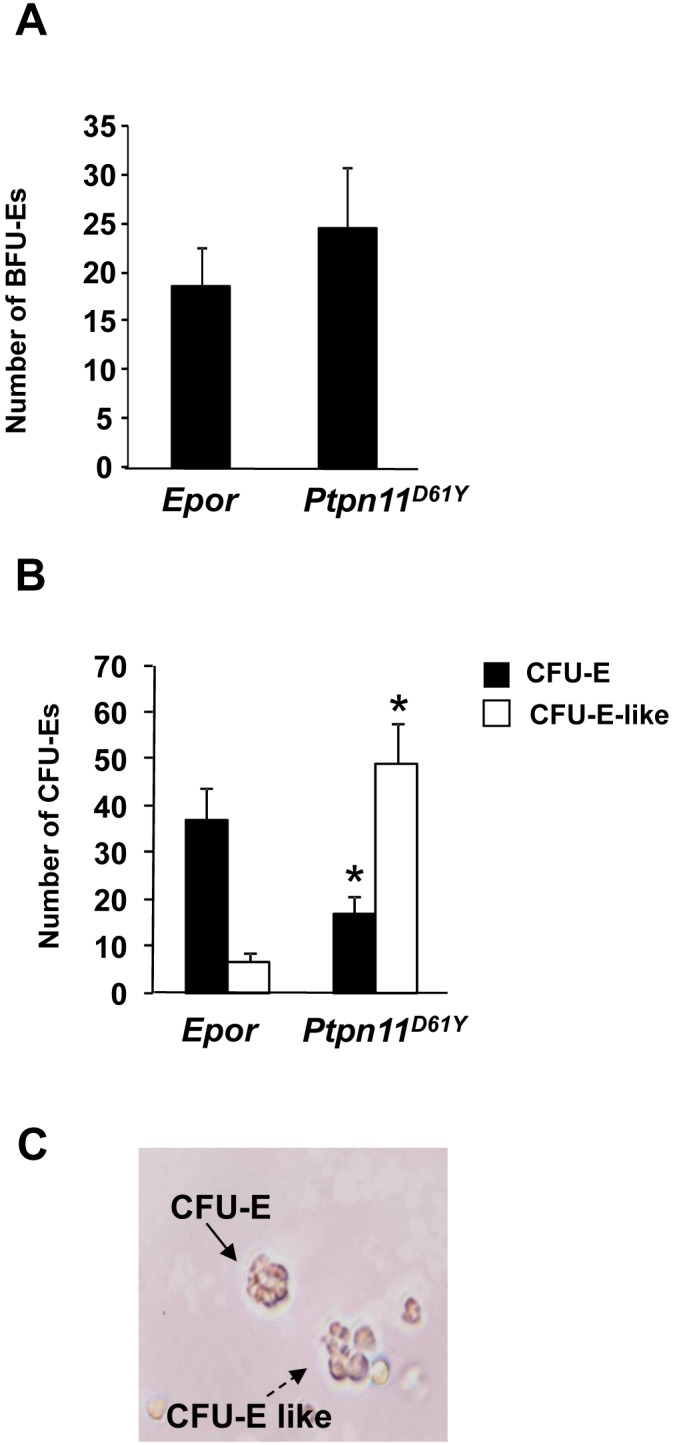
Erythroid differentiation of Ptpn11D61Y BM cells.(A) BFU-E assays performed using BM from Epor and Ptpn11D61Y mice. Numbers (mean ± SD, n = 6) of BFU-E per 5×104 cells plated are shown. (B) CFU-E assays of BM cells from Epor and Ptpn11D61Y mice. Numbers (mean ± SD, n = 6) of CFU-E and CFU-like colonies per 5×104 cells plated are shown. *p≤0.05, ANOVA. (C) Representative picture of CFU-E with immature phenotype.